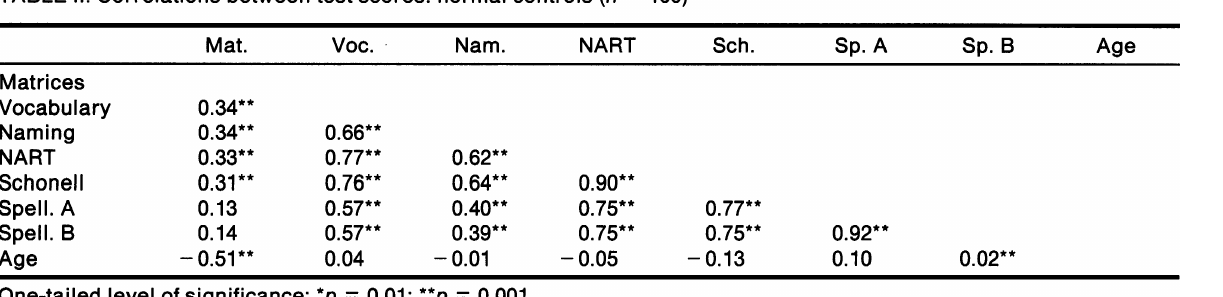
TABLE II. Correlations between test scores: normal controls (n =